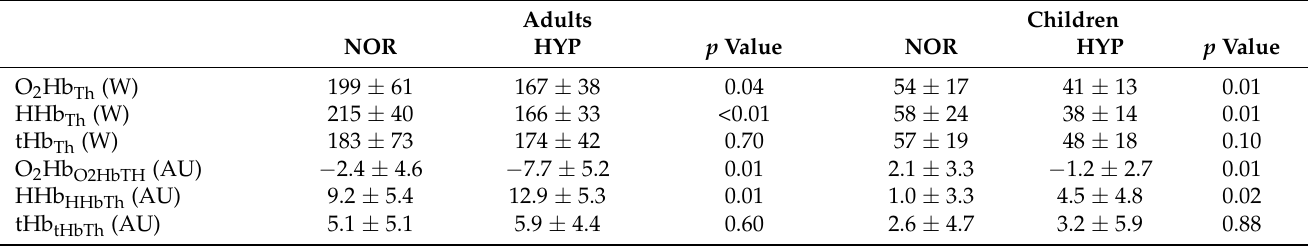
Table 3. Power outputs at muscle oxygenation thresholds and muscle oxygenation (vastus lateralis) parameters at respective thresholds in adults and children at submaximal intensities during normoxic (NOR) and hypoxic (HYP) exercise testing sessions. Adults Children